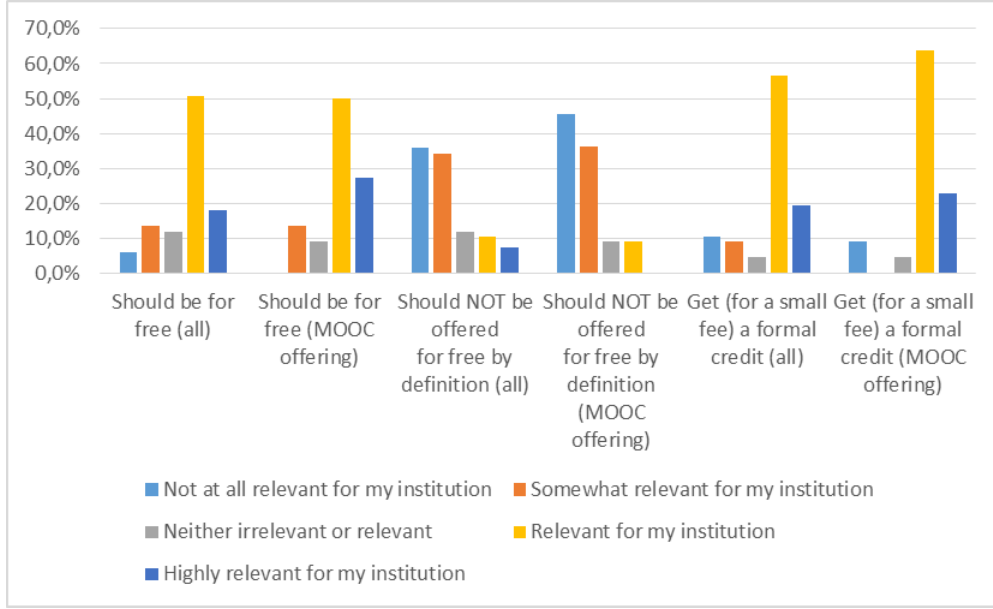
Figure 10a . The importance of the open dimension in MOOCs (dimension 3, 4 and